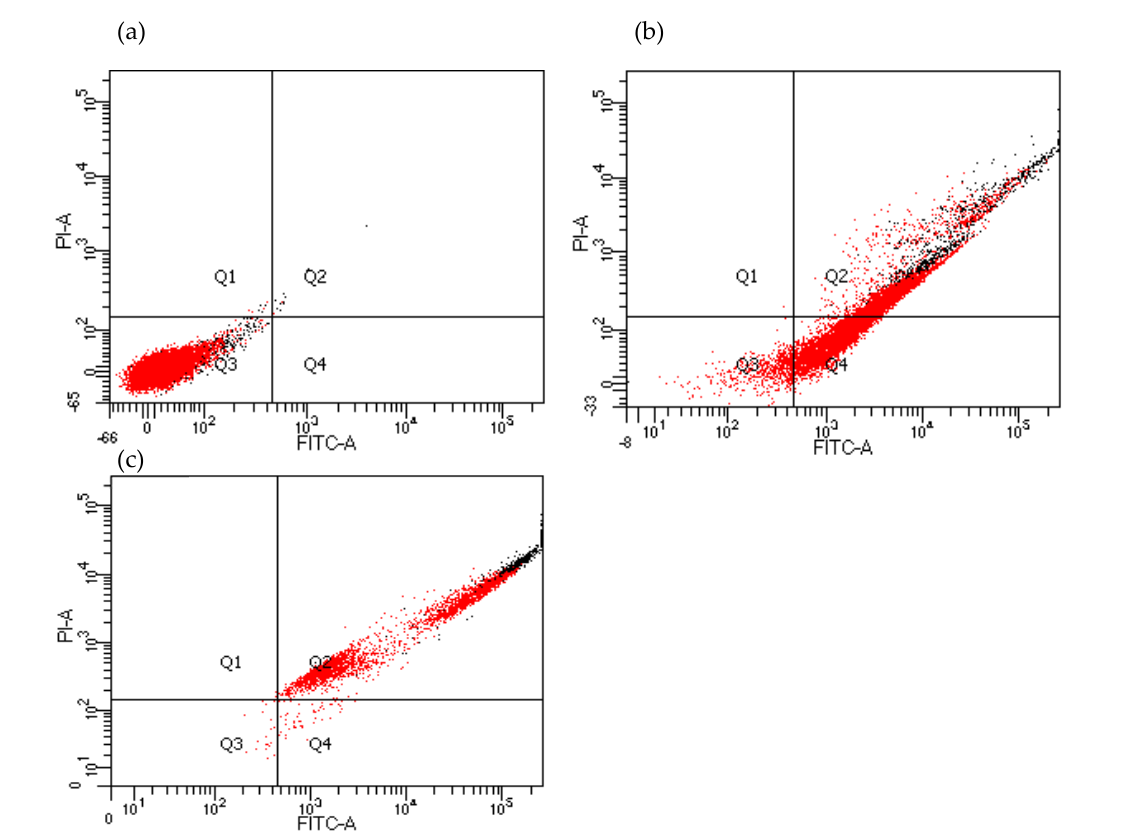
Figure 4. Fluorescence activated cell sorting (FACS) analysis of the inhibitory effects of breast (MCF-7) cancer cells using bioactive extracts at pH 5.2 (best IC50 concentration). The results were compared to the inhibitory effects of a commercially-available cancer drug, cucurmin. ( a ) Untreated cells, ( b ) cells treated with extract, and ( c ) cells treated with curcumin, all at cell concentration of 1 × 10 6 cells/well.